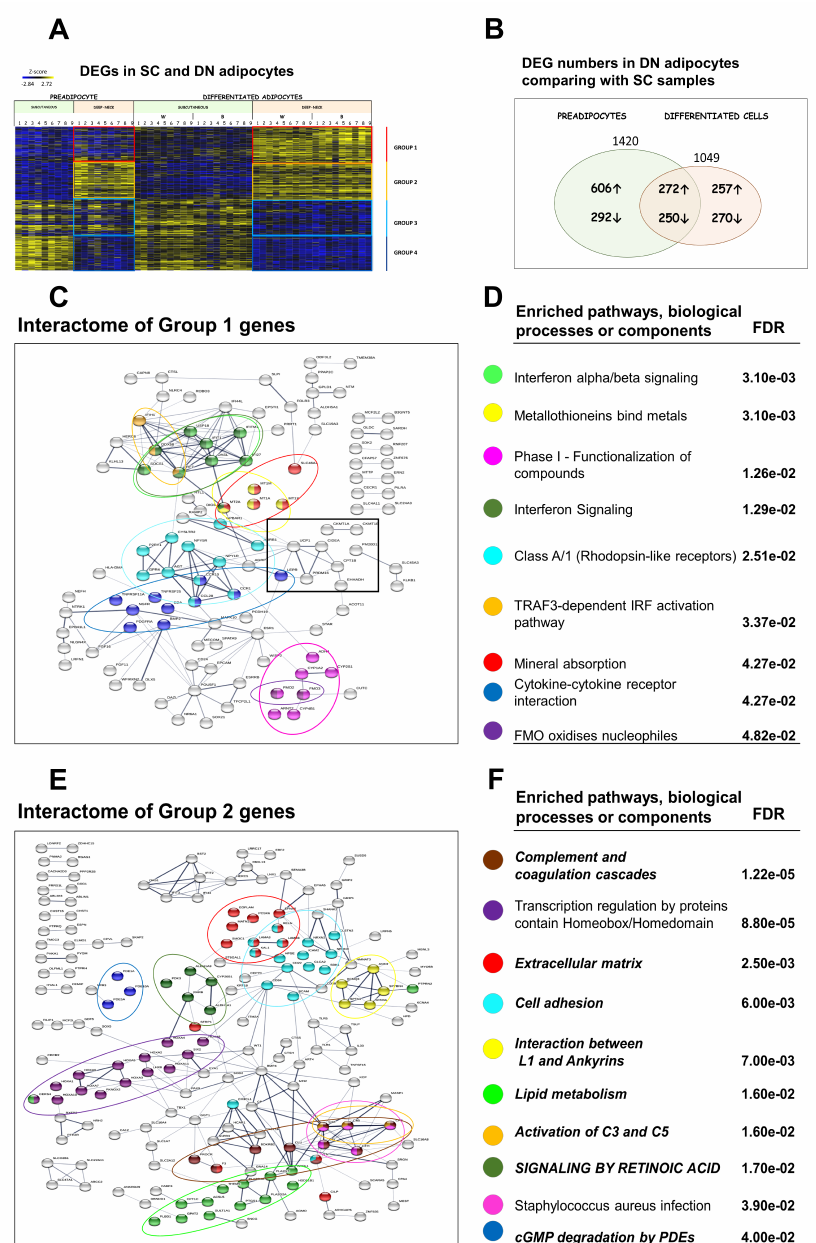
Figure 3. Di ff erentially expressed genes (DEGs) in subcutaneous (SC) and deep-neck (DN) mature adipocytes. ( A ) Heat map shows the expression profile of 1049 DEGs in SC and DN mature adipocytes. Based on how these DEGs are expressed in preadipocytes, four distinct groups were formed (Group 1–4). 1 to 9 labels the individual from which the sample was obtained. ( B ) Venn diagram shows the DEG numbers based on DN and SC comparison at preadipocyte and di ff erentiated adipocyte state. ( C ) Interactome map and ( D ) Selected Significantly Enriched pathways and their false discovery rate (FDR) value based on DN vs. SC DEGs in Group 1; interaction score confidence value: 0.4. ( E ) Interactome map and ( F ) Selected significantly Enriched pathways and their FDR values in Group 2; interaction score confidence value: 0.4. Edges represent protein-protein based interactions. Italic font: pathway also appears in preadipocyte state; Capital letters: Pathway also appears in FTO obesity-risk allele-based comparison. W: white di ff erentiation protocol; B: brown di ff erentiation